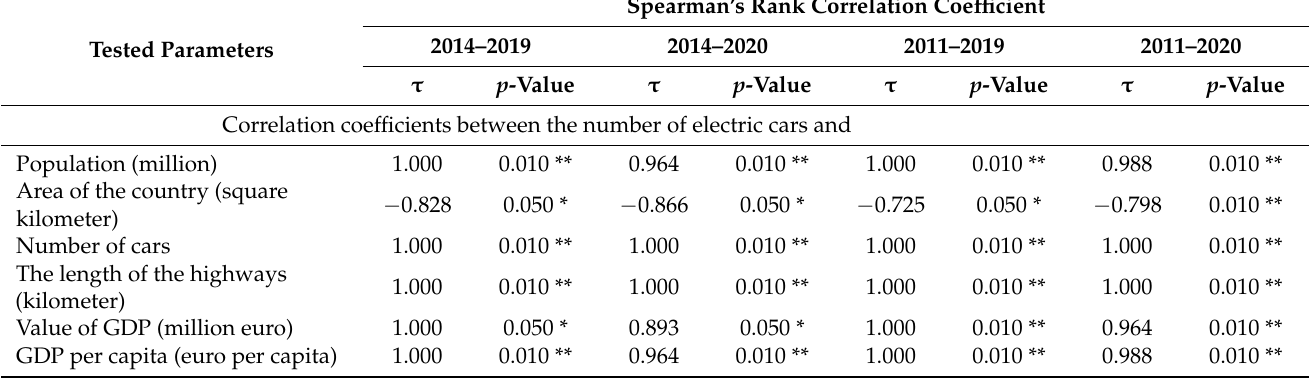
Table 6. Spearman’s rank correlation coefficients between the number of electric cars and social and economic parameters in